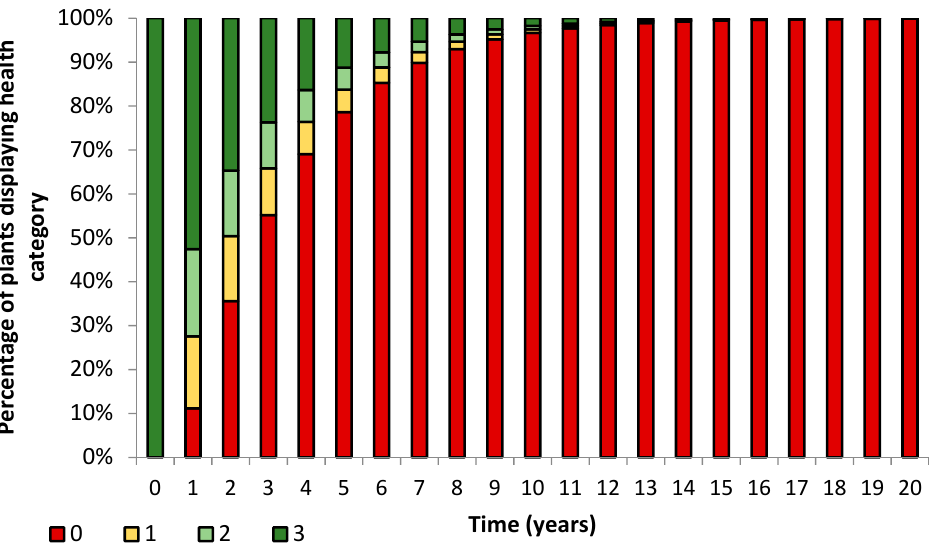
12 of 16 Table 1. Furthest distance (m) of dieback front movement (plant death) calculated from the closest dead plant (ignoring dead plants from previous years) in Transect 1 over a 7-year study. Trial es- tablished June 2005. Assessment